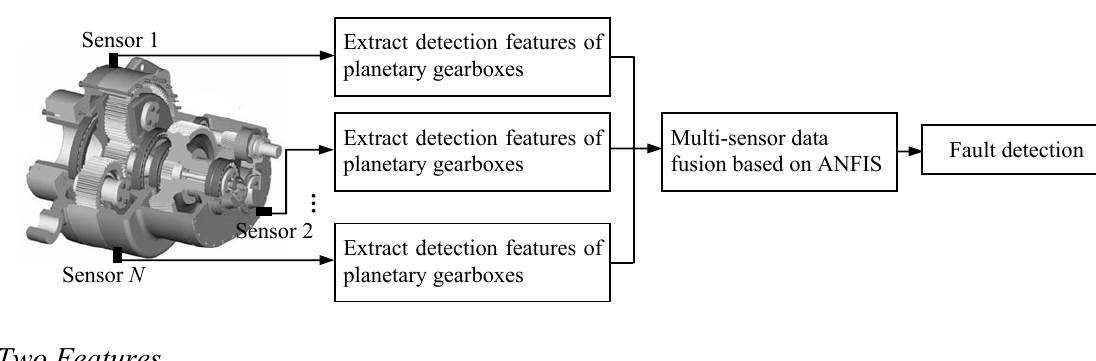
Figure 1. Flow chart of the proposed